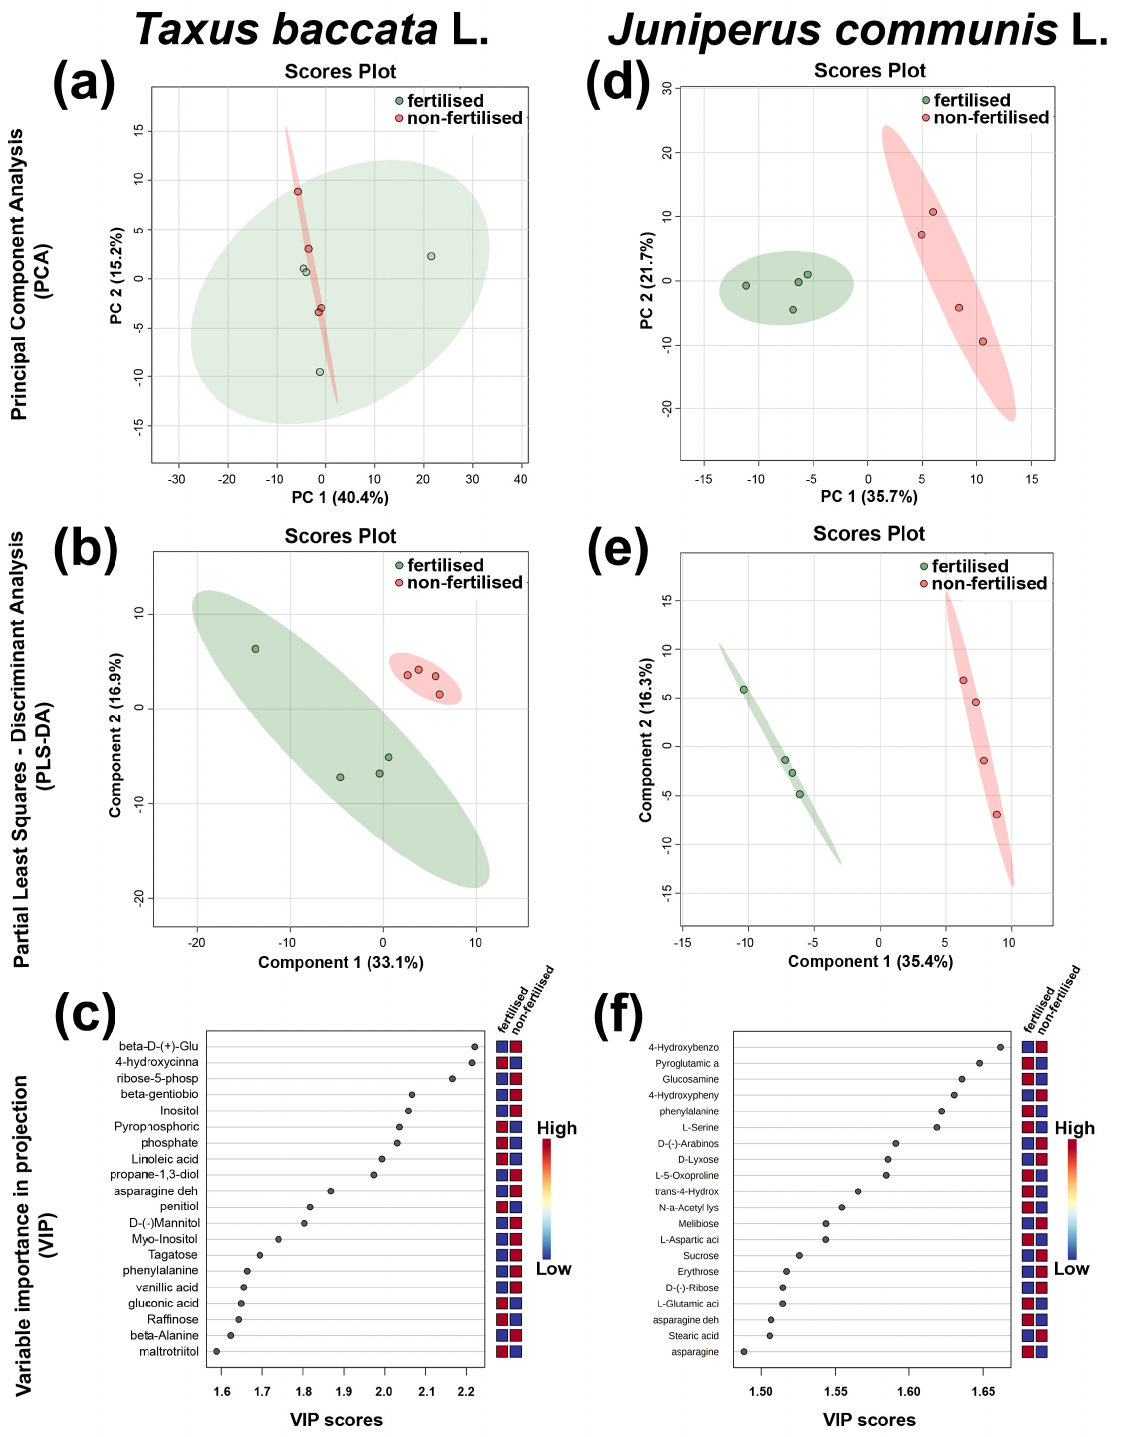
Figure 6. Results of the metabolome data analysis. ( a , d ) Principal Component Analysis scores— plot between the selected Principal Components (PC), and ( b , e ) Partial Least Squares–Discriminant Analysis (PLS-DA)—plot between the selected Principal Components (PC) showing separation between fertilised and non-fertilised dry seeds collected from Taxus baccata L. and Juniperus communis L. plants, grown in fertilised (green) and non-fertilised (red) conditions. The explained variances are shown in brackets; ( c , f ) VIP scores showing the top 20 important metabolites that contribute the most to the PLS-DA plots of seeds. Colours in the variable importance in projection plot represent relative intensities, where red and blue symbolise higher and lower values,